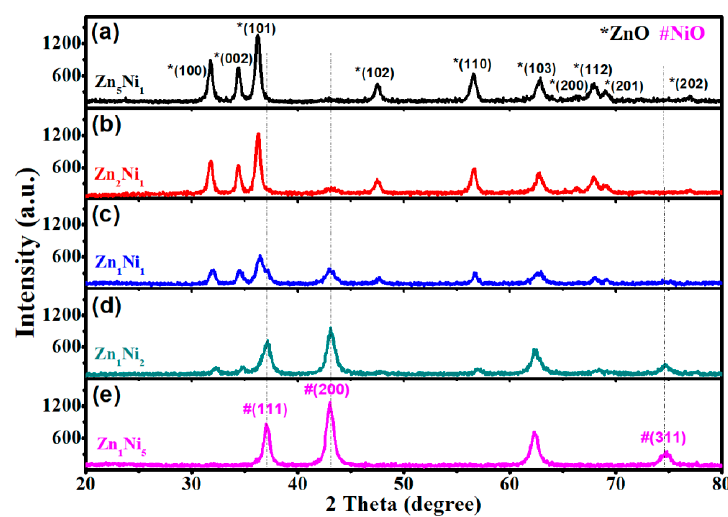
Figure 2. XRD patterns of the 3D n -ZnO/ p -NiO hierarchical structures with the different molar ratios of Zn and Ni: Zn 5 Ni 1 ( a ), Zn 2 Ni 1 ( b ), Zn 1 Ni 1 ( c ), Zn 1 Ni 2 ( d ), and Zn 1 Ni 5 ( e ).